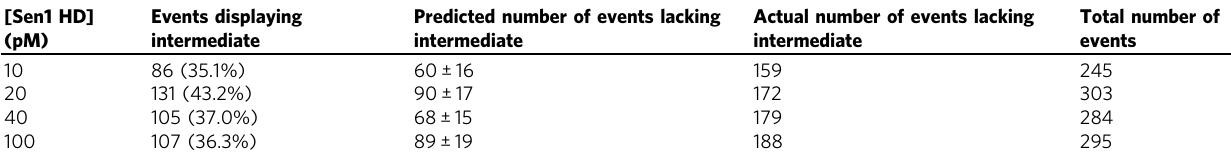
Table 3 Summary of the number of events displaying or not displaying intermediates [Sen1 HD] (pM)